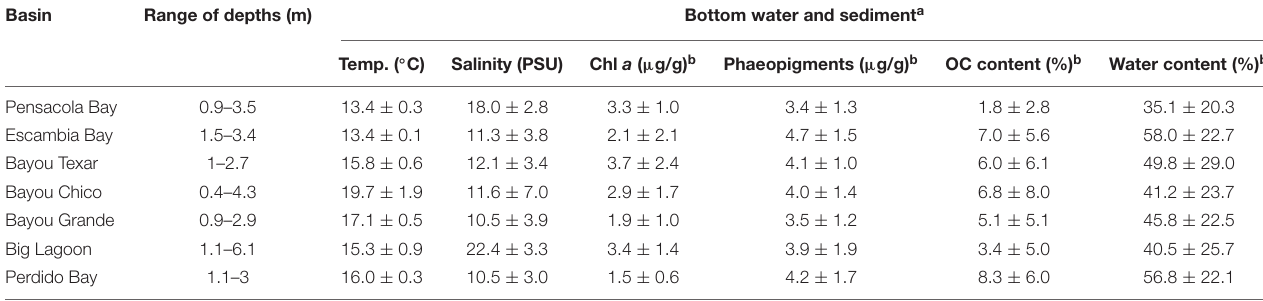
a Mean ± SD. b Sediment parameter. TABLE 2 | Abundances of culturable Vv in sediments and surface waters. Basin Sediment (CFU/mL)